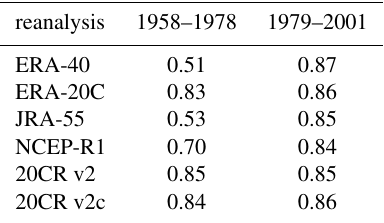
Table 2. Correlation between the monthly mean Southern Annu- lar Mode at 850hPa with the Marshall (2003) station-based index during the pre- and postsatellite periods. Note that correlations are virtually identical if we compare with the 1000hPa indices, as op- posed to 850. While the station-based index is available from 1957 to present, we focus on these periods to optimize availability of re- analyses; in particular, ERA-40 is only available for complete years from 1958 to 2001.